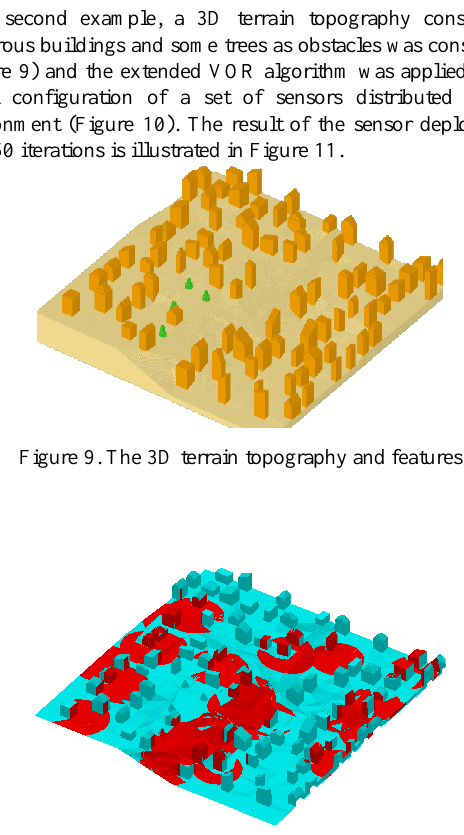
Figure 10. Coverage of the sensors (red regions) for Initial